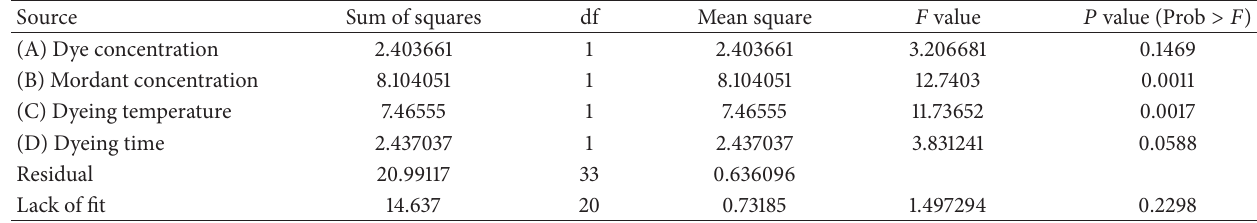
Table 3: ANOVA results obtained from fitting the linear model to experimental design space of dyed samples with Prangos ferulacea .